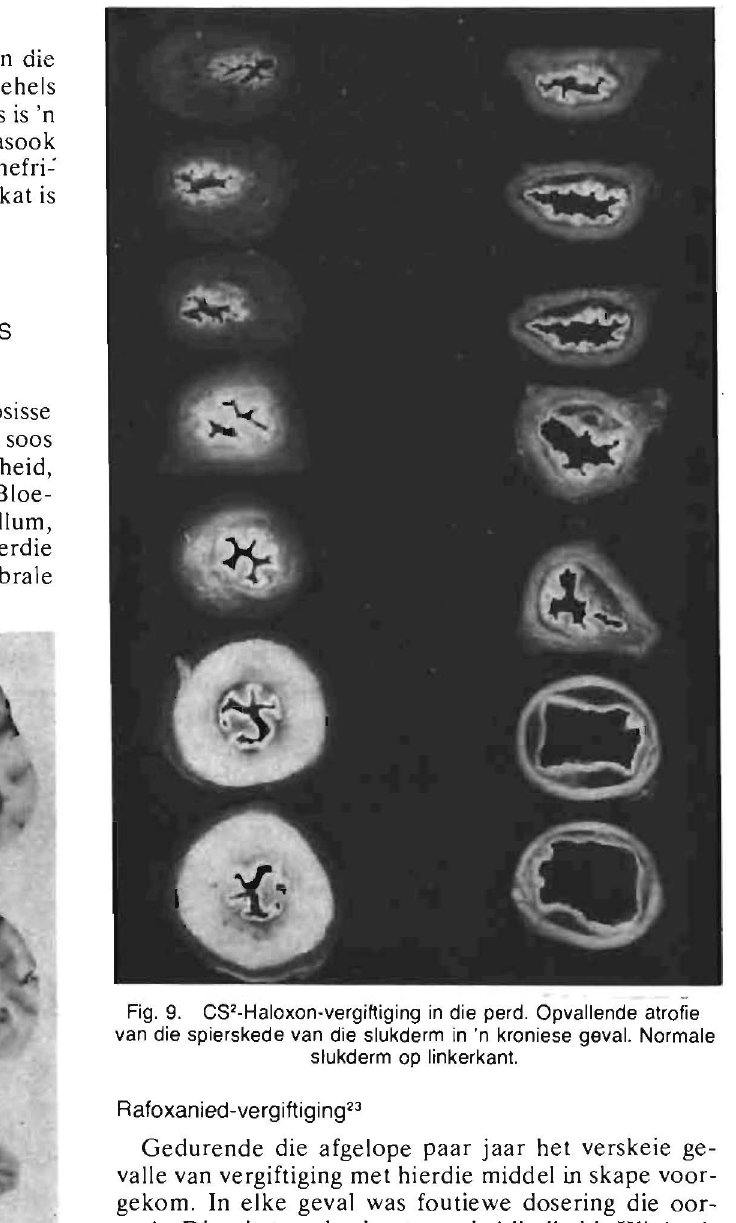
Fig. 9. CS2-Haloxon-vergiftiging in die perd. Opvallende atrofie van die spierskede van die slukderm in 'n kroniese geval. Normale slukderm op